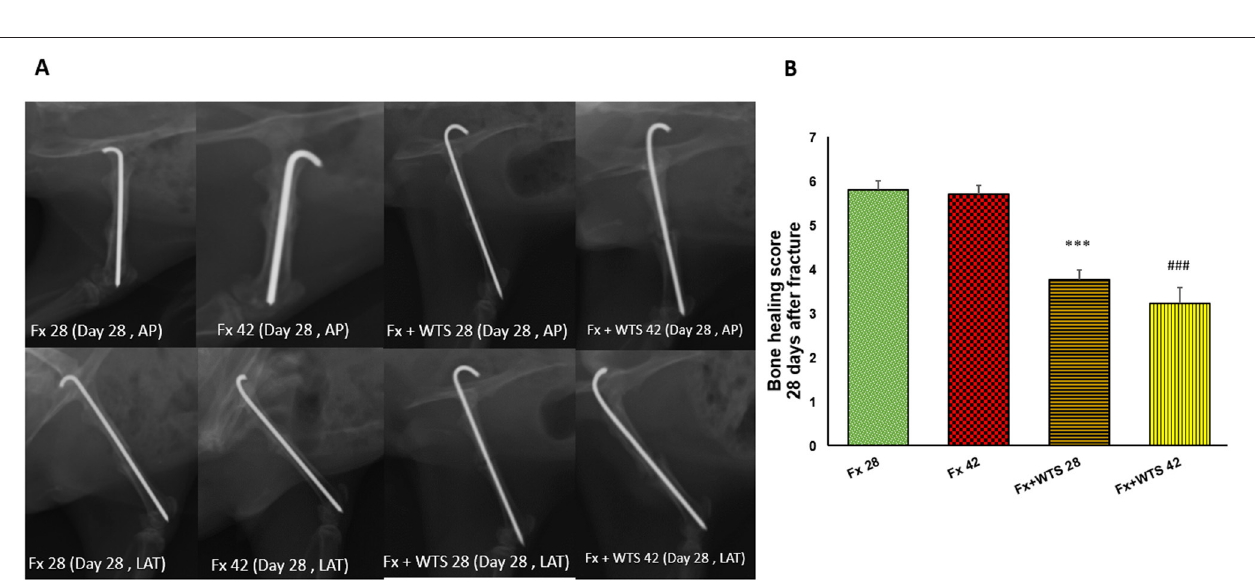
FIGURE 5 | Radiographic evaluation revealed WTS decreased the process of fracture healing in 28 days after fracture. (A) X-ray images of lateral and AP view of femur (B) the score of bone healing in experimental groups. Fx 28: group subjected to room air for 28 days after surgery and femoral bone fracture, Fx 42: group subjected to room air for 42 days after surgery and femoral bone fracture, Fx + WTS 28: group subjected to Waterpipe tobacco smoking for 28 days after surgery and femoral bone fracture, Fx + WTS 42: group subjected to Waterpipe tobacco smoking for 42 days after surgery and femoral bone fracture. The results are presented as mean ± SE, n = 10. *** P < 0.001 vs. Fx28; ### P < 0.001 vs. Fx 42.